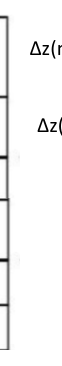
Telescoping Δz from (n+1) th cell Figure 2. Cell definition in the vertical direction in ENVI-met. The temperature profiles of four orientations (north, south, west and east) along N h Figure 2. Cell definition in the vertical direction in ENVI-met. different heights are generated from ENVI-met. The value of N h should respect the thermal zone definition regarding the height and in DBES tool and the cell definition in the vertical direction in ENVI-met. This will be described in detail in Section 3.3. The temperature profiles are inputted in the weather generation tool Meteocalc (which is integrated in COMFIE) and 4.N h corresponding site-specific weather files are generated. Then, the simulation is performed 4.N h times in COMFIE to obtain reference simulation results for each thermal zone. The whole coupling method is shown in Figure